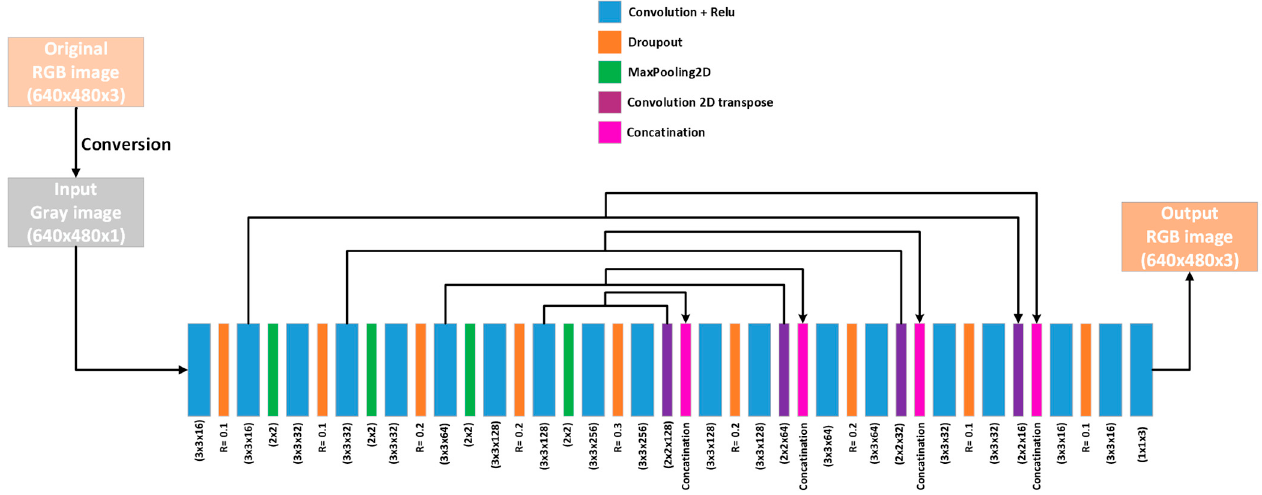
Figure 1. The CNN architecture of the proposed method (UNet architecture with adding a 1 × 1 convolution layer with 3 output filters). Each layer type is represented with a different color. The original RGB image is converted to grayscale, and the output is an RGB image.